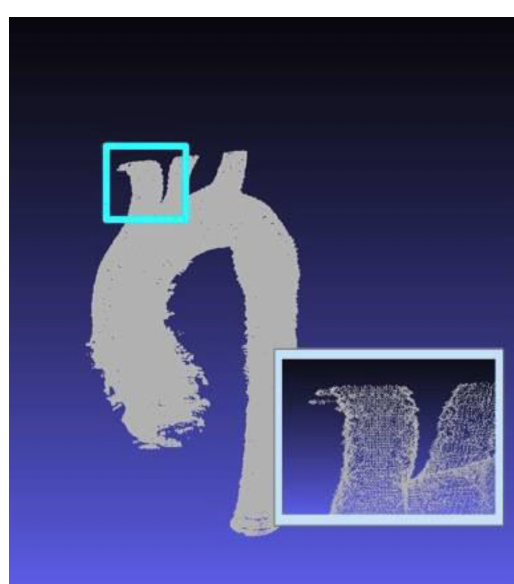
Fig. 1.3 - The multiple dots that make up the dataset. The brachiocephalic artery and portions of the left common carotid artery are magnified in the